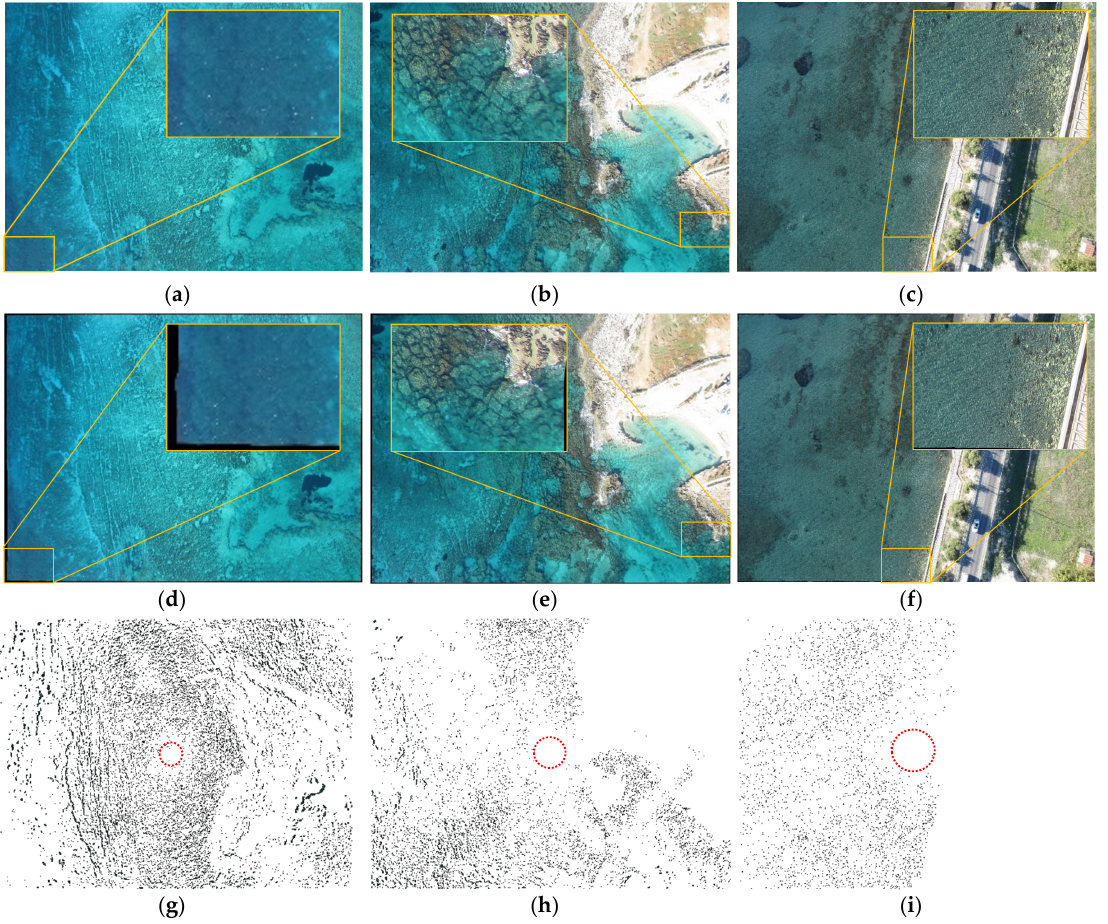
Figure 7. Initial aerial data (first row), refraction-free images (second row), and their subtraction (third row).